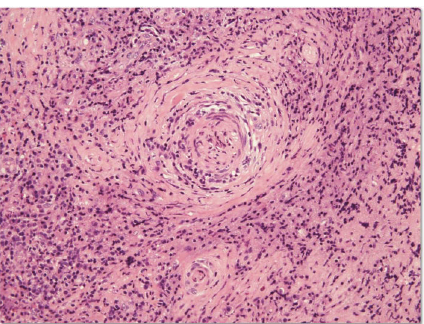
Figure 5: Histology of paranasal sinus biopsy specimens. Paranasal sinus biopsy specimens showing vasculitis with fibrinoid necrosis and small-size artery obliterated by concentric inflammatory cells with granulomatous inflammation (hematoxylin and eosin stain- ing).